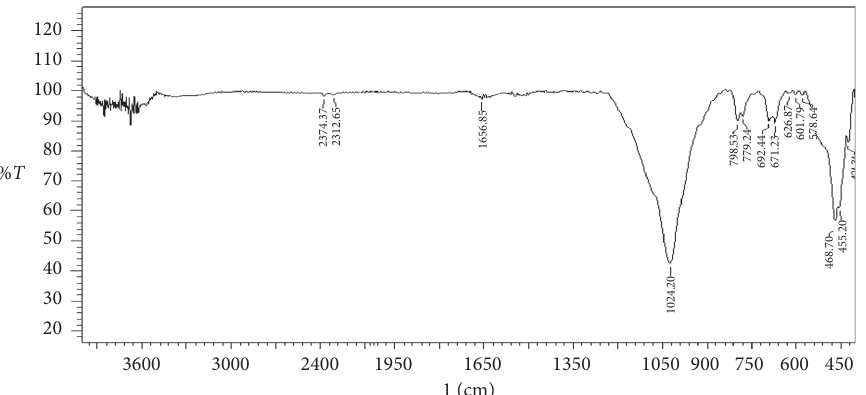
Figure 9: Infrared spectrum of the modified sepiolite.